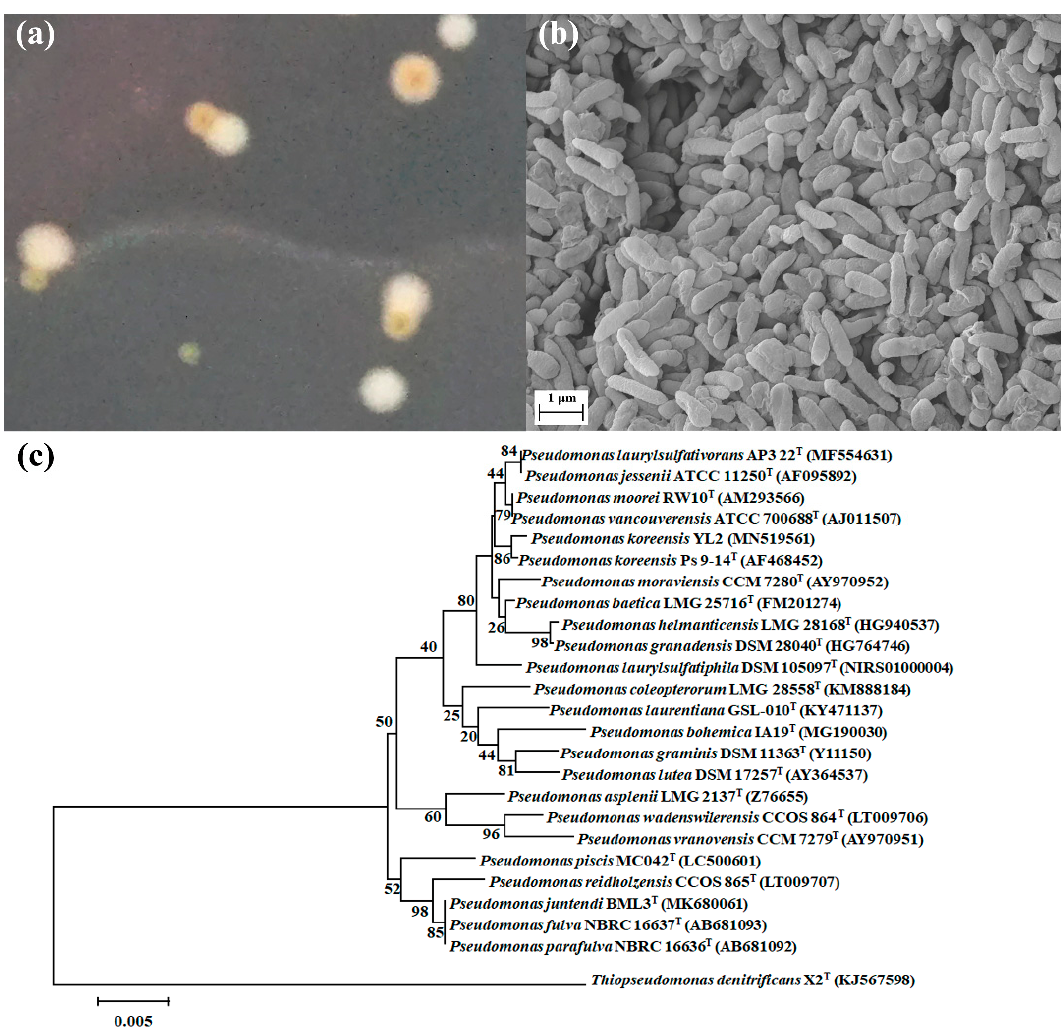
Figure 1. Colonies on MSM–SMX–agar plates. Orange colonies of the strain YL2 grew around the beige colonies of strain YL1 ( a ); Scanning electron microscopy (SEM) image of strain YL2 ( b ). Phylogenetic tree showing the relationship between strain YL2 and other related strains based on 16S rRNA gene sequences ( c ).